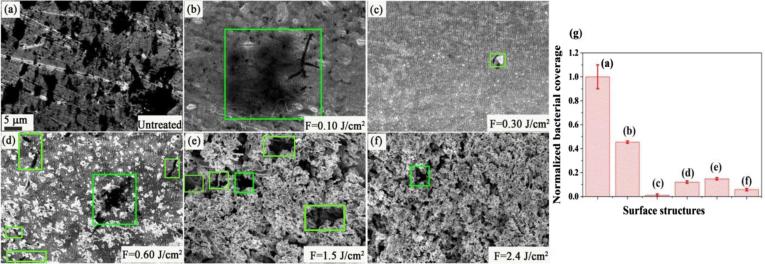
Representative E. coli attachment and biofilms formation on the unstructured (control) and laser-induced structured samples at different fluences after 24 h incubation. (a) SEM image of bacterial colonization and biofilms (black areas) on the untreated Au surface. (b-f) Bacterial colonization on the structured surfaces treated at different fluences. The scale-bar of 5 µm is same for (a-f). Clearly, the structured surfaces prevent the formation of bacterial colonies. The green frames shown are the region for bacterial colonization. (g) The normalized surface coverage for E. coli cells after 24 h on unstructured and laser-structured samples. The values are normalized to the colonized surface on the unstructured surface. (For interpretation of the references to colour in this figure legend, the reader is referred to the web version of this article.)